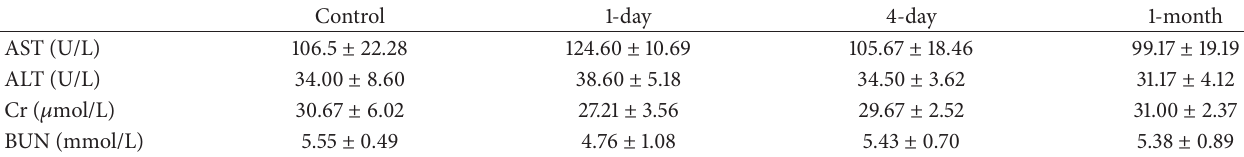
Figure 5: Light photomicrographs of tissue sections (HE). Compared with the control, there were no pathologic changes in the experimental groups. 𝑛 = 6 ; scale bar = 100 𝜇 m. Table 2: Serum AST, ALT, Cr, and BUN levels in the four study